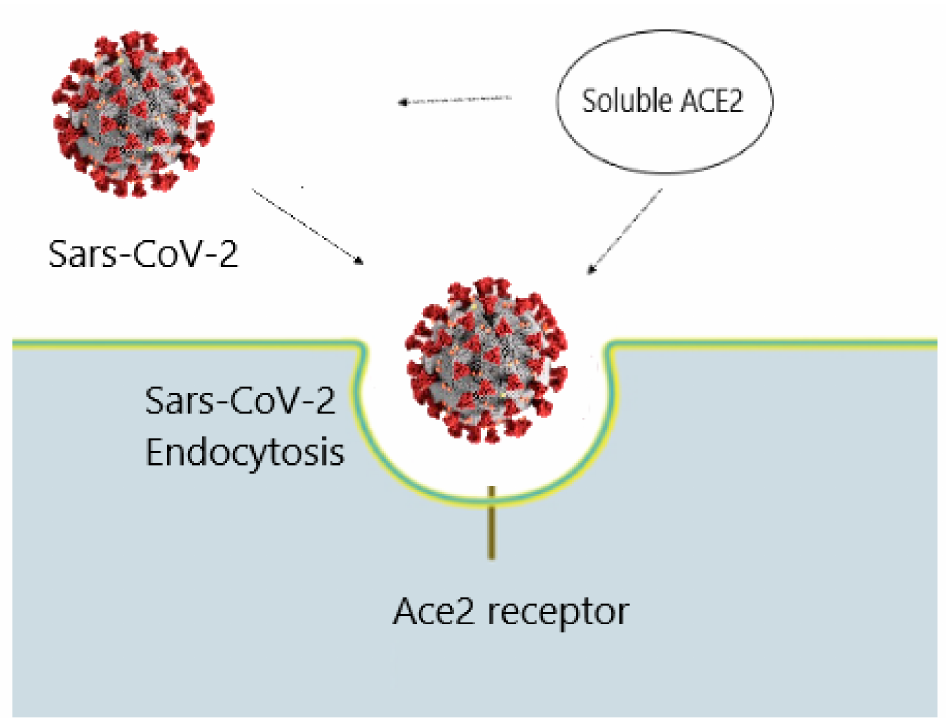
Figure 2. Soluble ACE2 binding prevents SARS-CoV-2 attachment to membrane ACE2, reducing viral endocellular